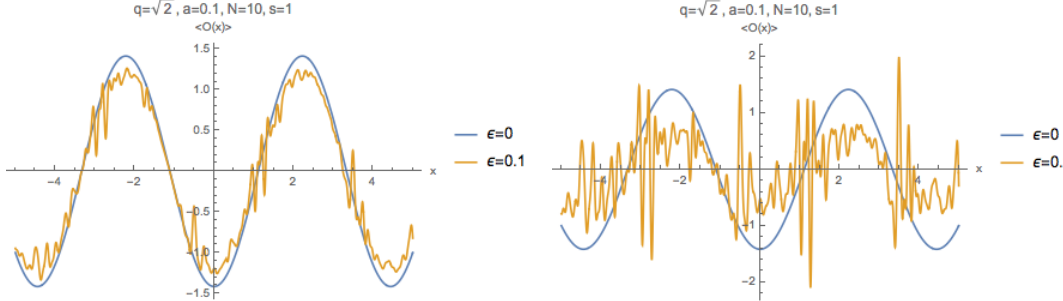
p 2 x N P A n cos ( ! n x + (cid:13) n ) for di(cid:11)erent n =1